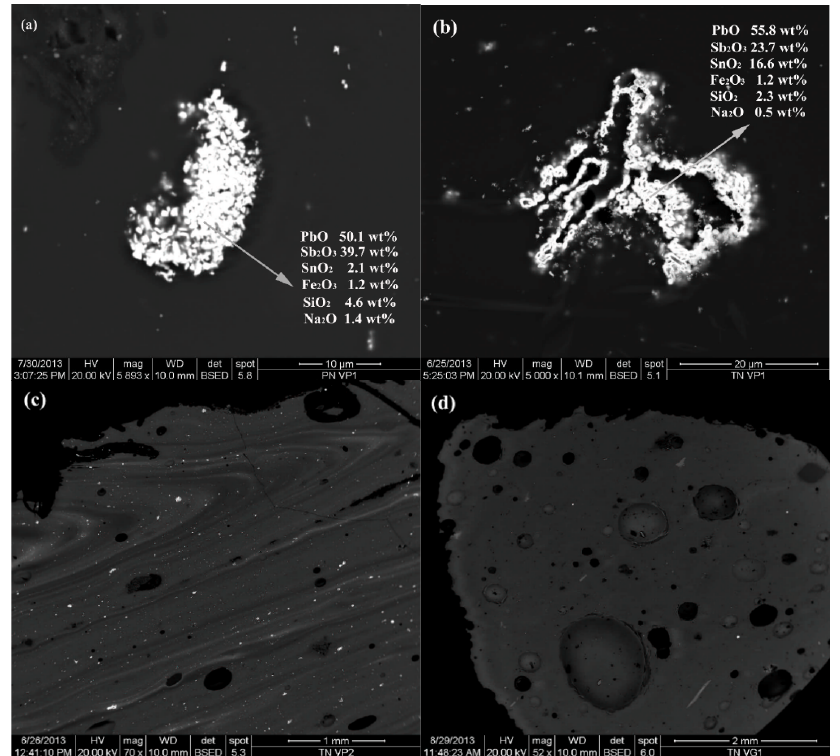
Figure 7. SEM-BSE images of Pb-antimonate opacified tesserae showing: ( a ) subhedral habit of Pb-antimonate (tessera PN VP1); ( b ) anhedral habit of Pb-antimonate (TN VP1); ( c , d ) various micro-textures of the glassy matrix shown by Pb-antimonate opacified tesserae (TNVP2 in ( c ) and